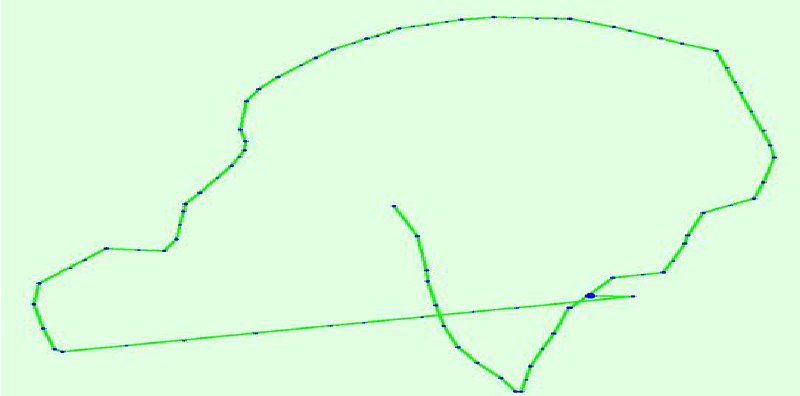
Figure 8. UAV flight line to obtain nadir images. Lines represent the drone flight path; dots repre- sent image capture positions on the flight path.